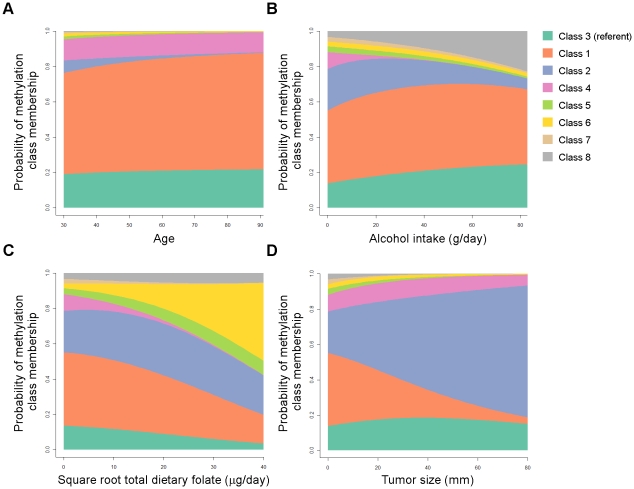
Probability of methylation class membership is significantly associated with tumor size, patient age, alcohol intake, and dietary folate when controlling for potential confounders in a multinomial logistic regression model.Results from a multinomial logistic regression plot the probability of methylation class membership versus covariates controlled for age, race, alcohol consumption, total dietary folate, tumor stage (low vs. high), tumor grade, tumor size, estrogen receptor status, and histology. The referent class (methylation class 3) is on the bottom of the plot in blue-green, remaining classes are plotted in numeric order from bottom to top as shown in the legend. (A) Patient age is significantly associated with methylation class membership (Overall Wald P<0.0001), and all methylation classes except class 4 are individually significantly associated with patient age. (B) Alcohol consumption is significantly associated with methylation class membership (Wald P<0.0001), and methylation classes 2, 4, 5, and 8 are individually significantly associated with alcohol intake. (C) √Total dietary folate intake is significantly associated with methylation class membership (Wald P<0.0001), and all methylation classes are individually significantly associated with total dietary folate. (D) Tumor size is significantly associated with methylation class membership (Wald P<0.0001), and all methylation classes except class 4 are individually significantly associated with tumor size.